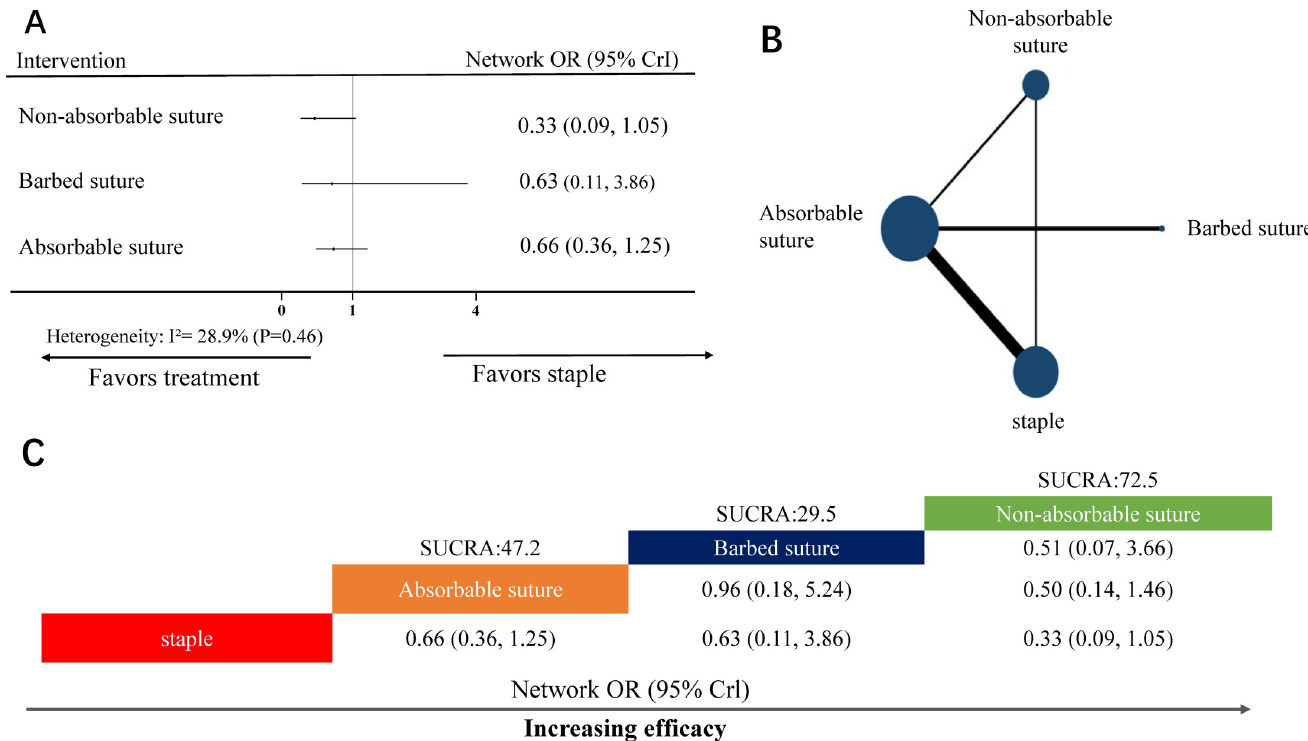
Fig 5. NMA for wound complications. (A) Forest plot of the network meta-analysis comparing each intervention against staple. (B) Each node (blue circles) represents a unique skin closure material; moreover, the size of each node represents the included pregnant woman for the intervention. The connecting line indicates direct comparisons between both nodes. The width of each line represents the number of direct comparisons between interventions. (C) Schematic detailing the most efficacious skin closure materials in NMA for wound complications, and surface under the cumulative ranking curve analysis (SUCRA) score. NMA, network meta-analysis; OR, odds ratio; CrI, confidence